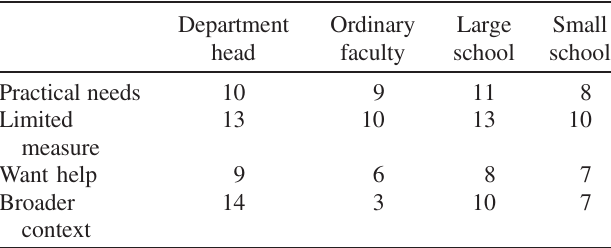
TABLE III. Distribution of faculty members and department heads across small and large schools (out of 10 ordinary faculty and 14 department heads, 14 large schools and 10 small